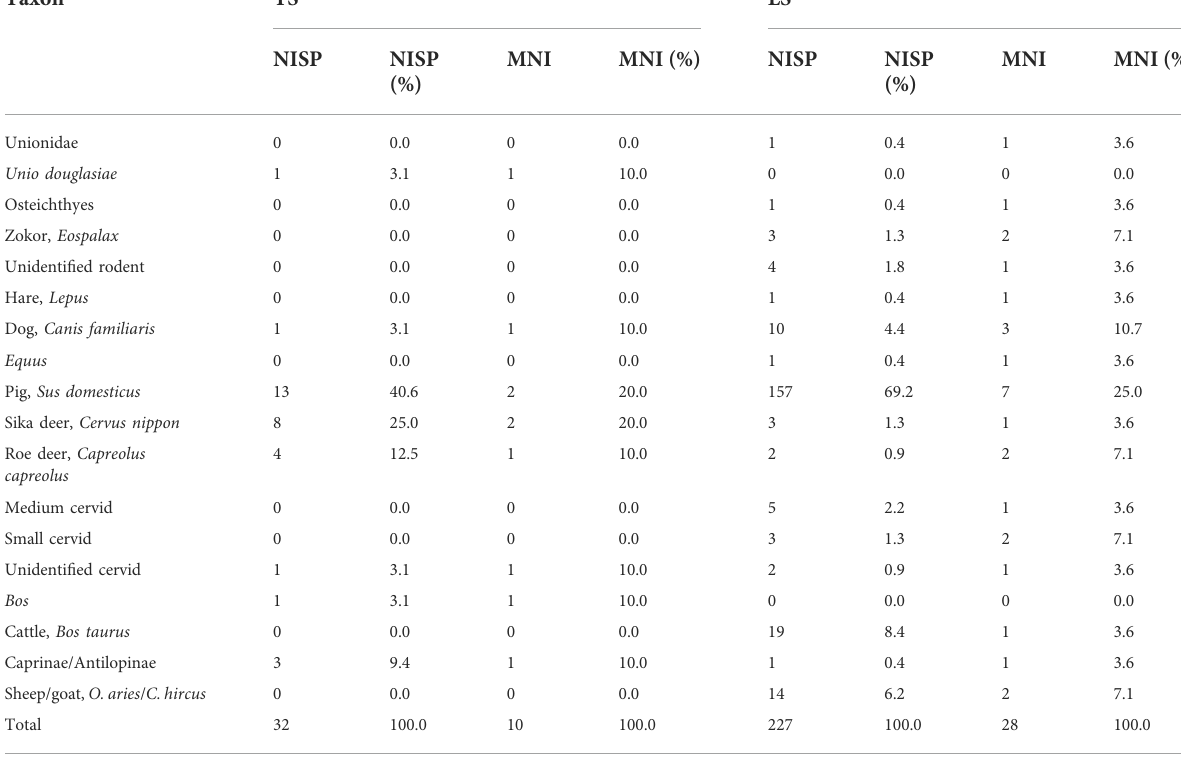
TABLE 1 NISP and MNI of animal remains from the YS and LS contexts at Xitou.